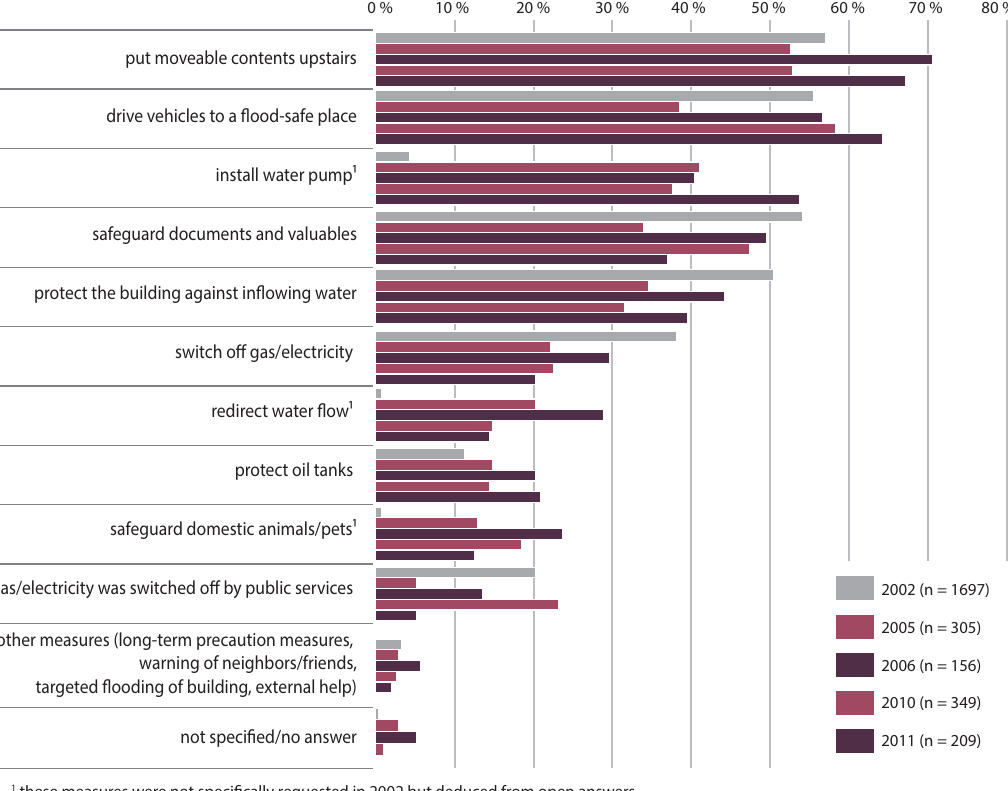
Figure 5. Emergency measures performed (in descending order), as a percentage of all people interviewed per year (multiple answers